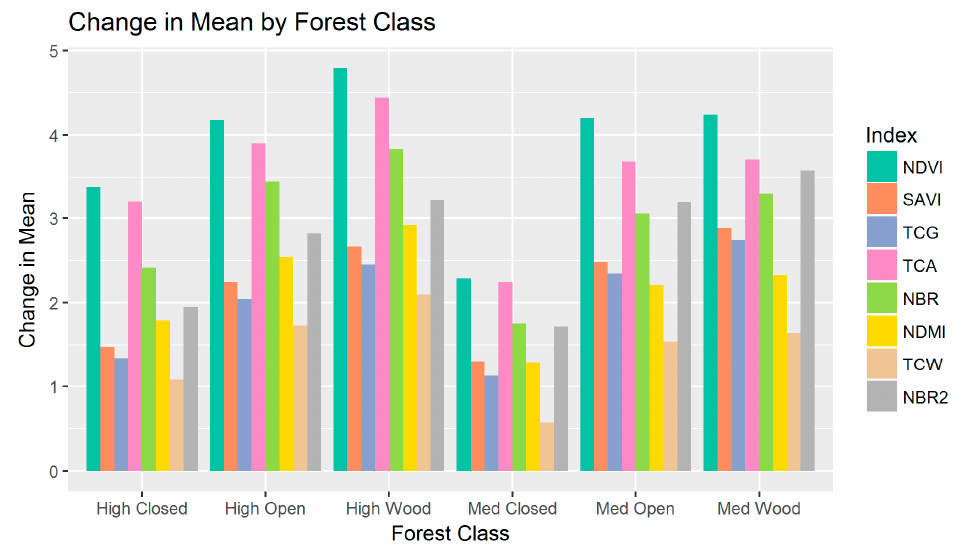
Figure 4. Change in mean directly following a fire, according to forest class (note values converted to